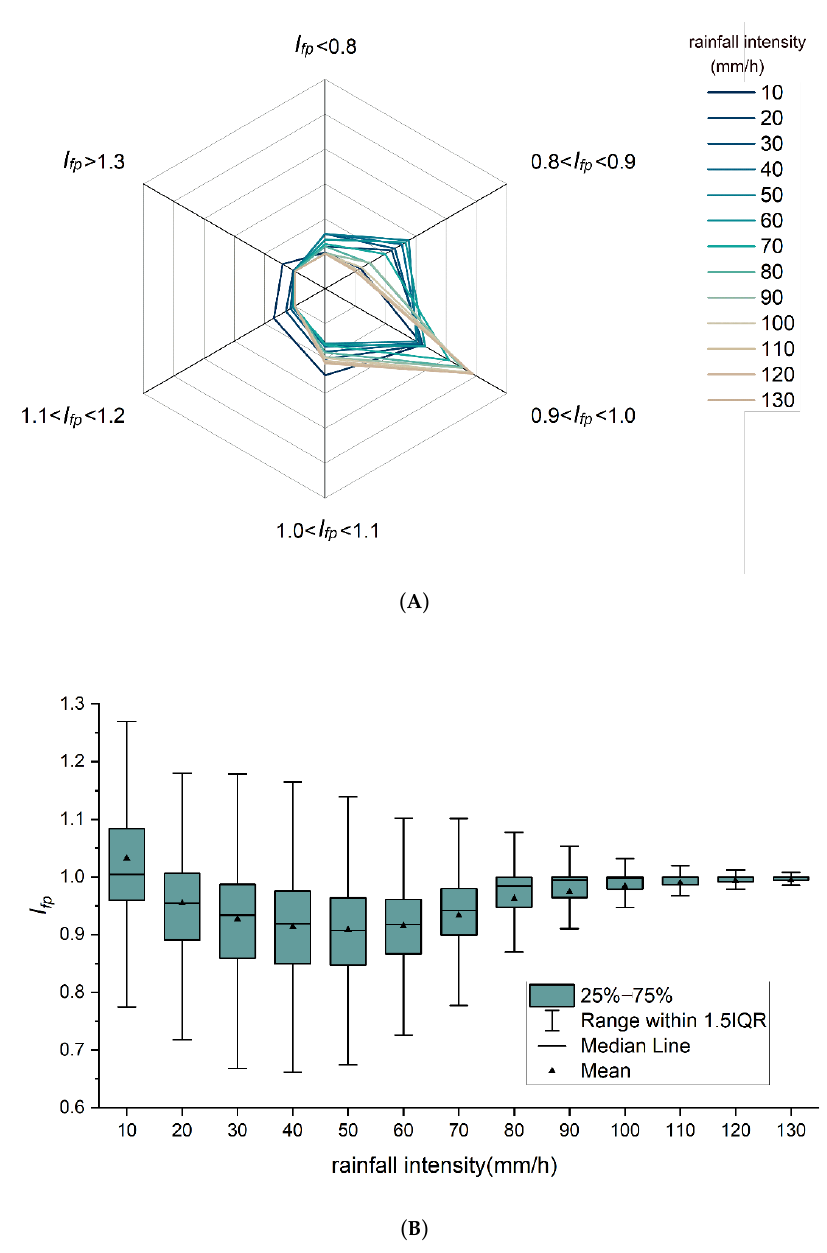
Figure 3. Influence of the rainfall intensity (RI) and rainfall movement direction (RMD) on the peak runoff. ( A ) The distribution of I fp values under 13 different RIs. ( B ) The distribution of I fp under different RIs.